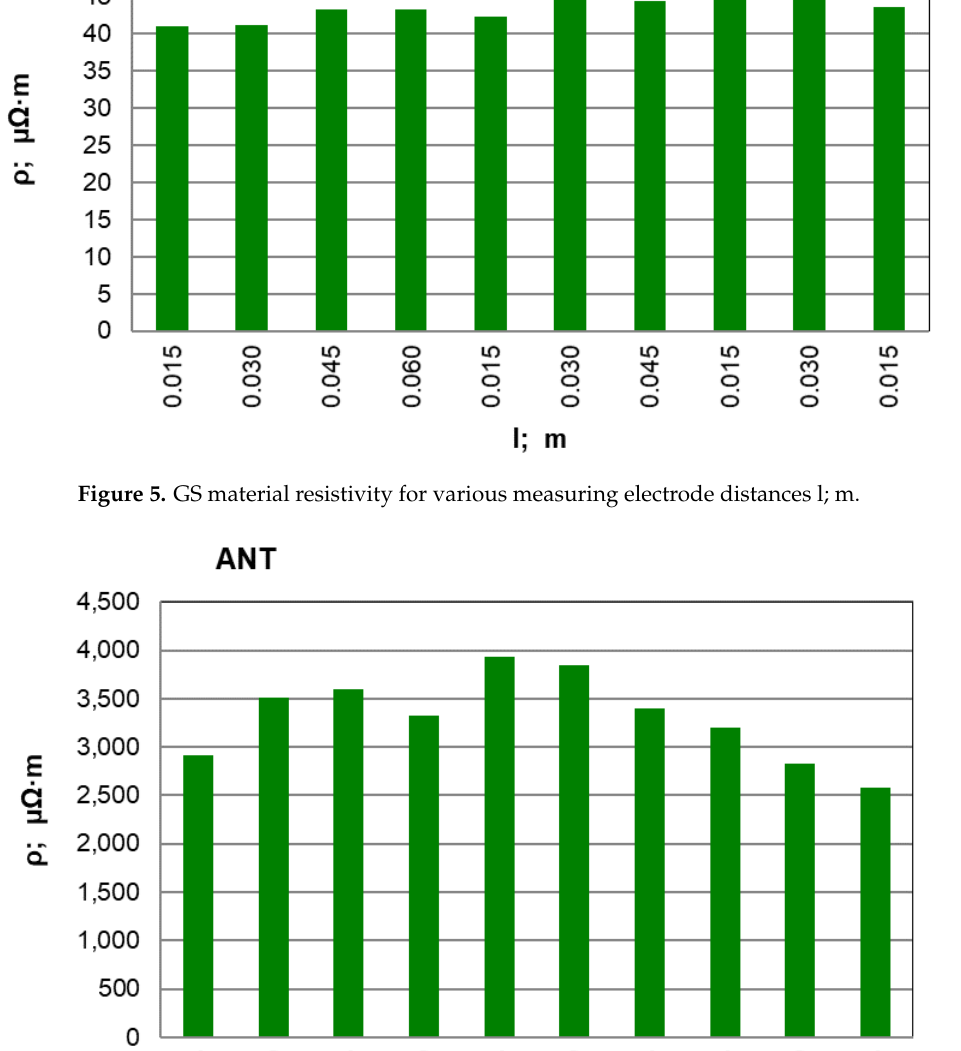
Figure 6. ANT material resistivity for various measuring electrode distances l; m